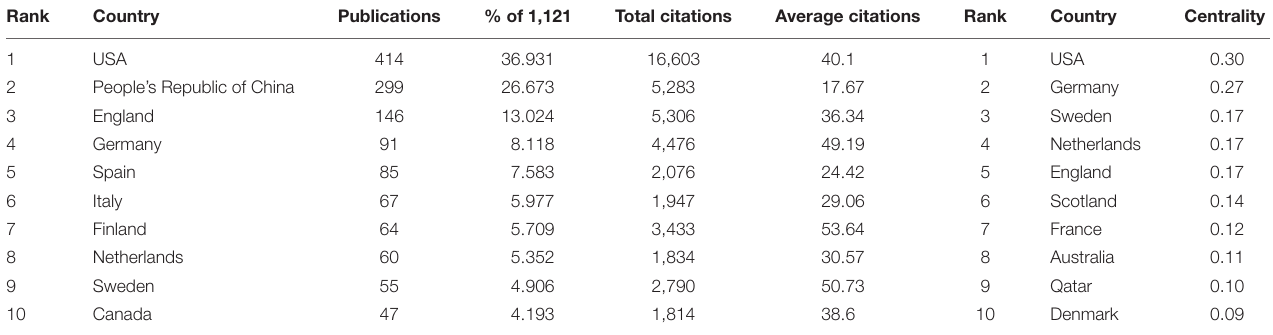
TABLE 1 | Top 10 countries by publications, citations, and centrality of coronary artery disease and metabolome research. Rank Country Publications % of 1,121 Total citations